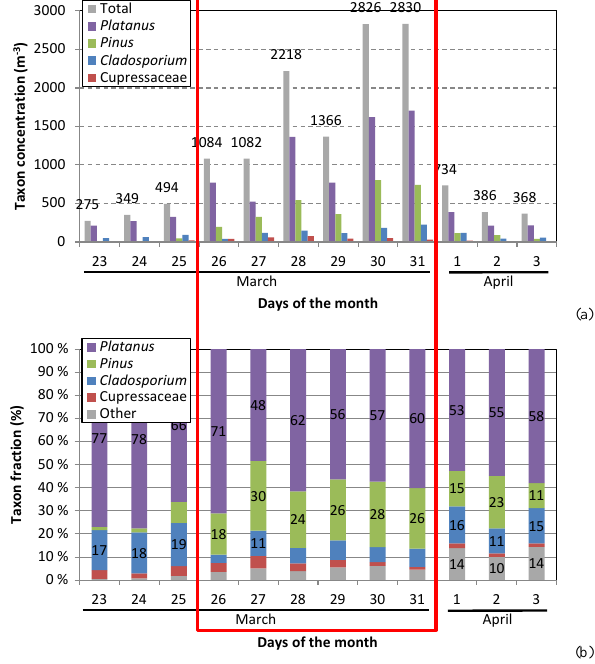
Figure 1. (a) Daily concentration of the four most abundant pollen ( Platanus , Pinus and Cupressaceae) and fungal spore ( Cladosporium ) taxa and total (pollen + spore), and (b) fraction of these four taxa during the period 23 March – 3 April, 2015. The red rectangle indicates the intense pollination event. The values of the total concentrations are reported in Figure 1a. The fractions higher than 10 % are reported in Figure 1b.